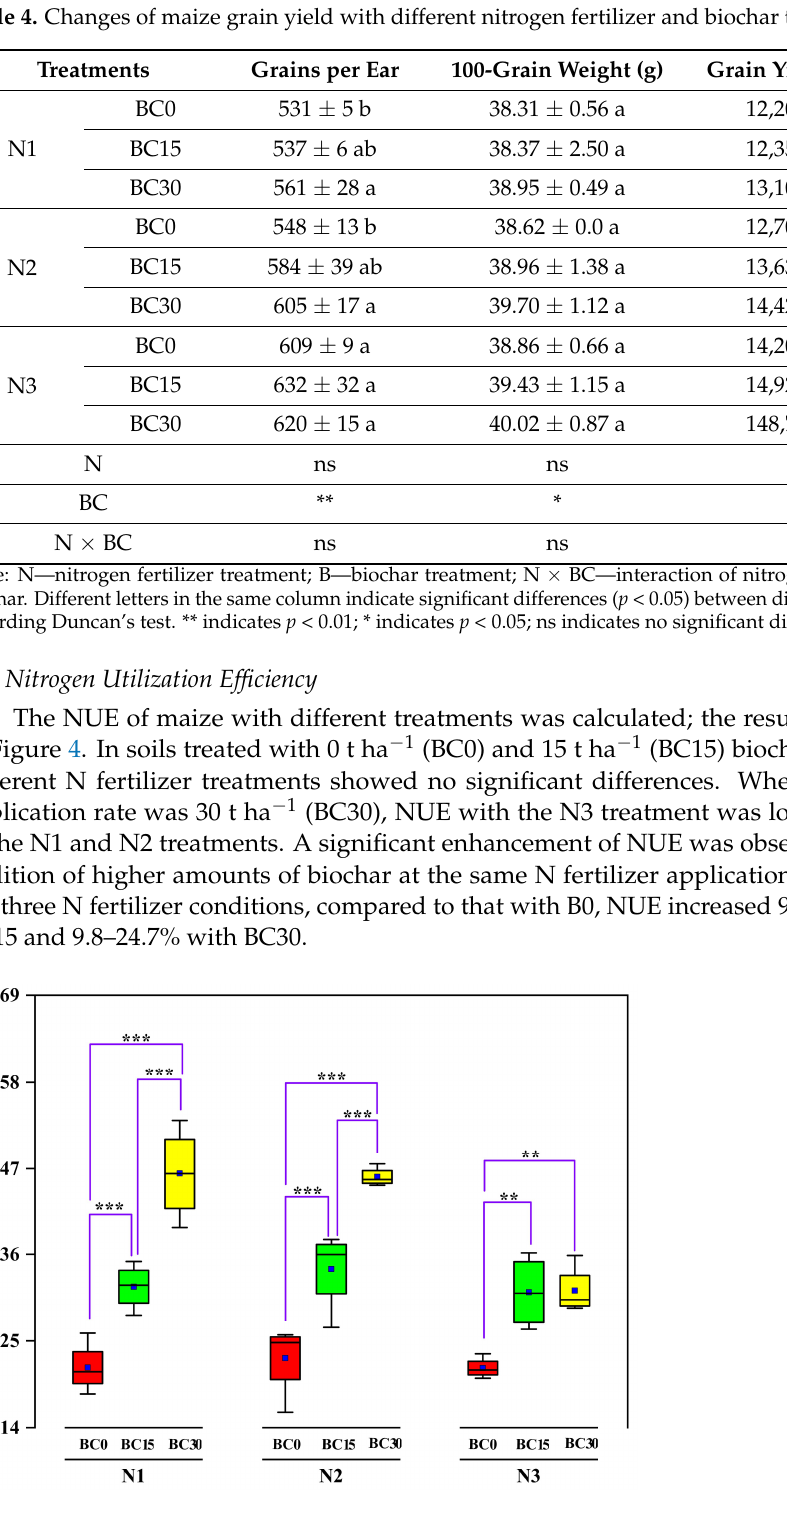
Figure 4. Impact of biochar on nitrogen utilization efficiency under different nitrogen fertilizer conditions. Significance levels are indicated: ** p < 0.01, *** p < 0.01.